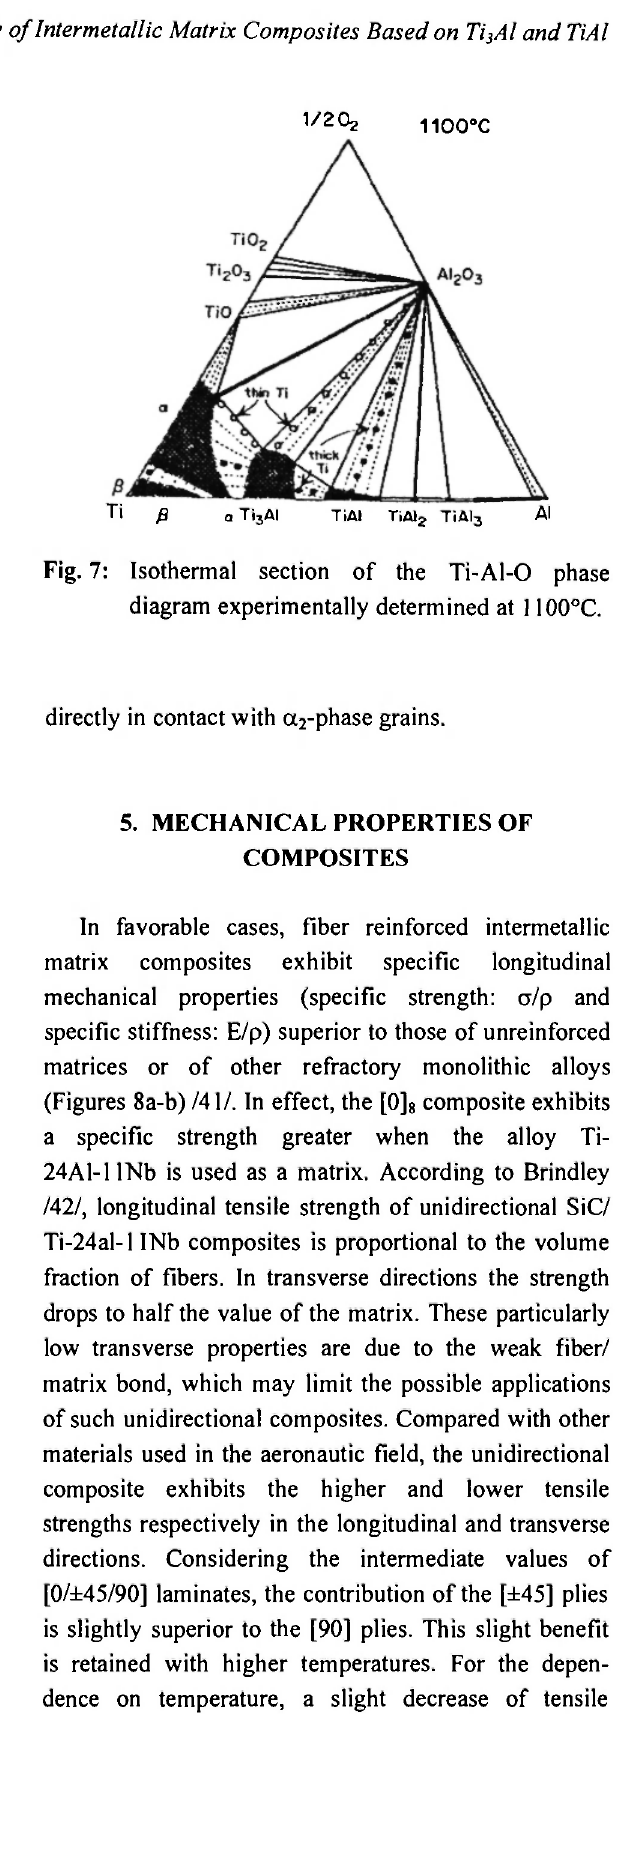
Fig. 7: Isothermal section of the Ti-Al-0 phase diagram experimentally determined at